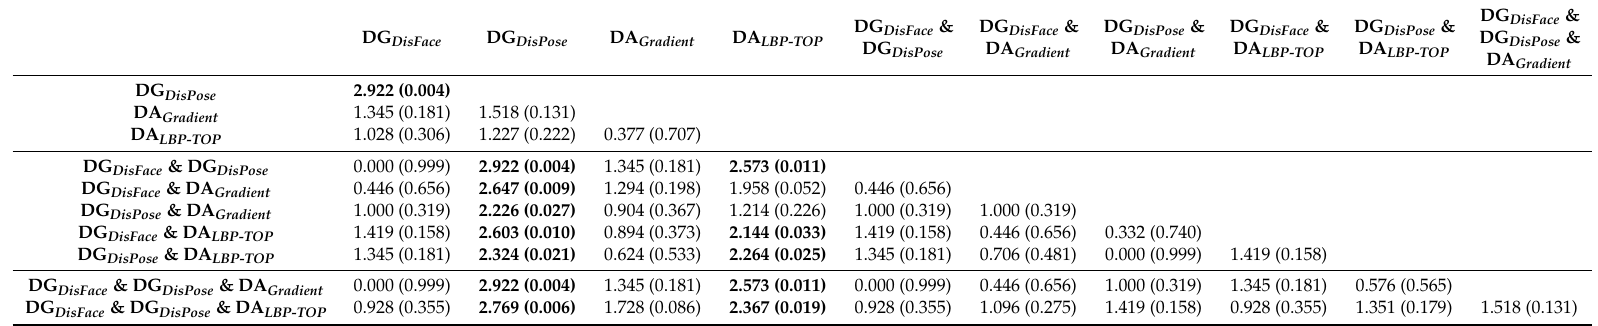
Table 2. Difference analysis of single facial feature and multiple facial